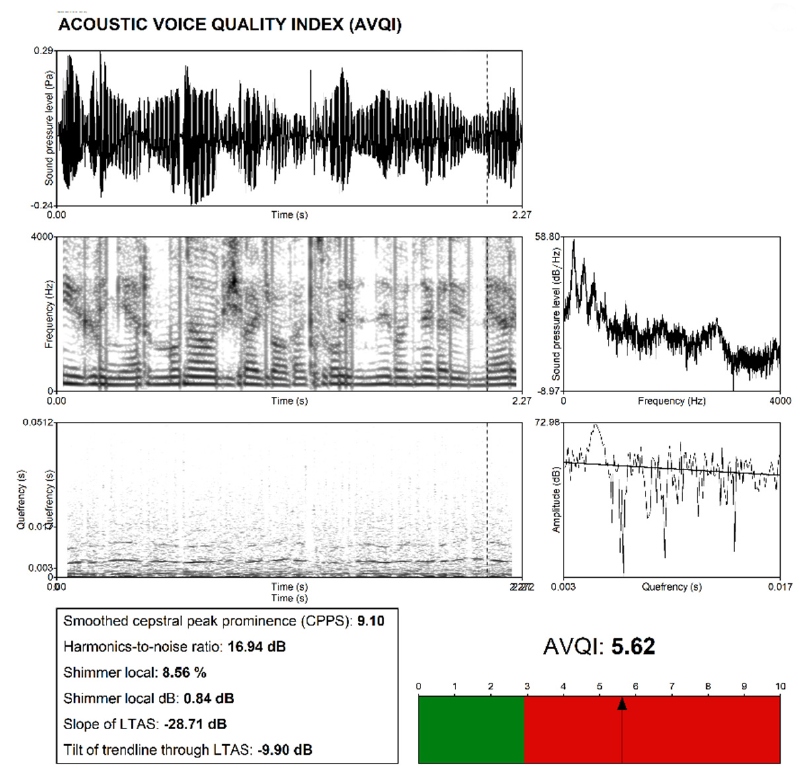
Figure 5. Acoustic assessment of the patient’s voice.